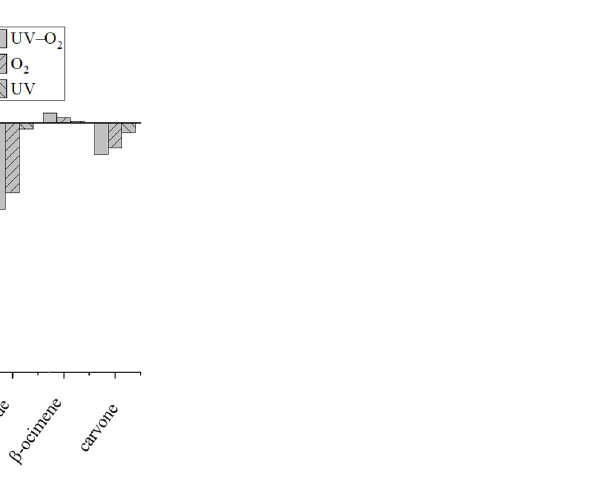
Figure 2. Variation of key aroma compounds in fried pepper oil under different storage conditions.